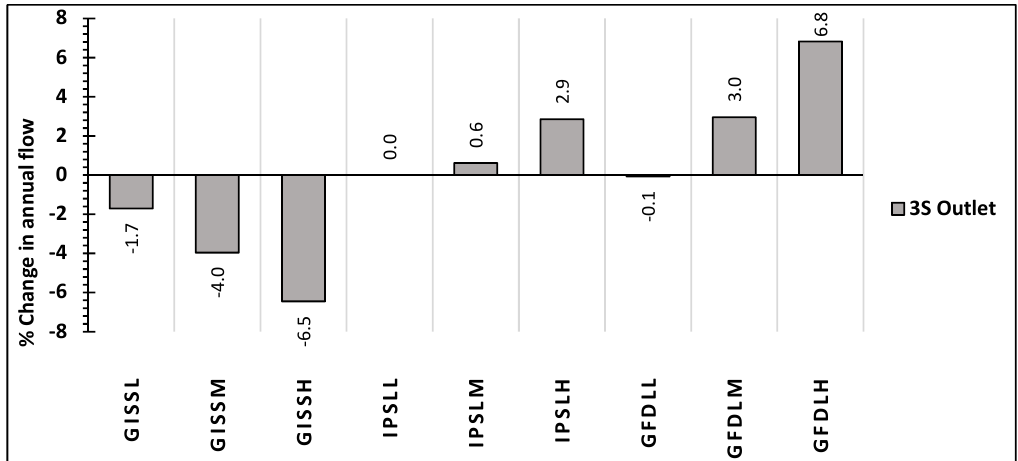
Figure 5. Percentage (%) change in annual precipitation under three emissions scenarios (L—low, M—medium and H—high emissions) for GCMs: ( a ) GISS model, ( b ) IPSL model and ( c ) GFDL model for 2051–2070 compared to the base line climate for period 1986–2005.